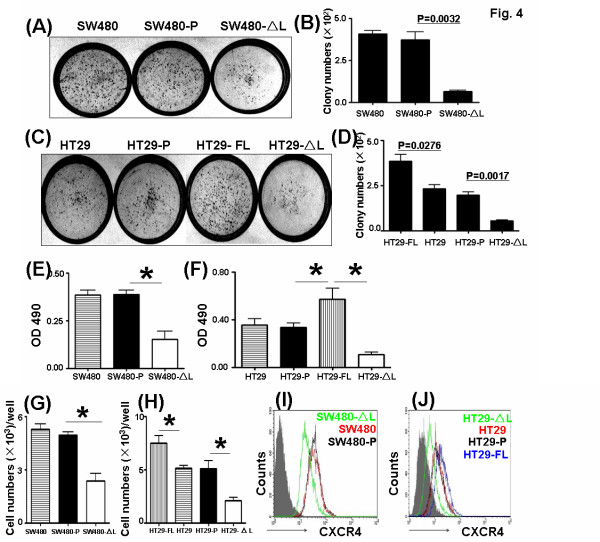
LEF-1-ΔL reduced the abilities of colony formation and adhesion in SW480 and HT29 cells. (A) and (C) Colony-forming assay. Fifty SW480 and HT29 cells expressing LEF-1-ΔL or LEF-1-FL were cultured in 35-mm plates, and colonies with more than 50 cells were counted on day 14 after the start of the culture. (B) and (D) Colonies in A and C were counted under light microscopy. Data are expressed as mean ± S.D. *P < 0.01. (E) and (F) 2 × 104 cells in A and C were added to wells in a 96-well plate, which was coated with BSA and matrigel. After incubation in a CO2 incubator at 37°C for 1 h, non-adherent cells were removed by washing with PBS. The number of adherent cells was counted with the MTT assay. (G) and (H) Cell migration assay. SW480 and HT29 cells expressing LEF-1-ΔL or LEF-1-FL were seeded in the upper chamber of a trans-well culture system, with SDF1a (100 ng/ml) in the lower chamber. Colon cells migrating into the lower chamber were analyzed by FACS and cell counting. (I) and (J) The expression of CXCR4 in cells in A and B was analyzed by FACS.